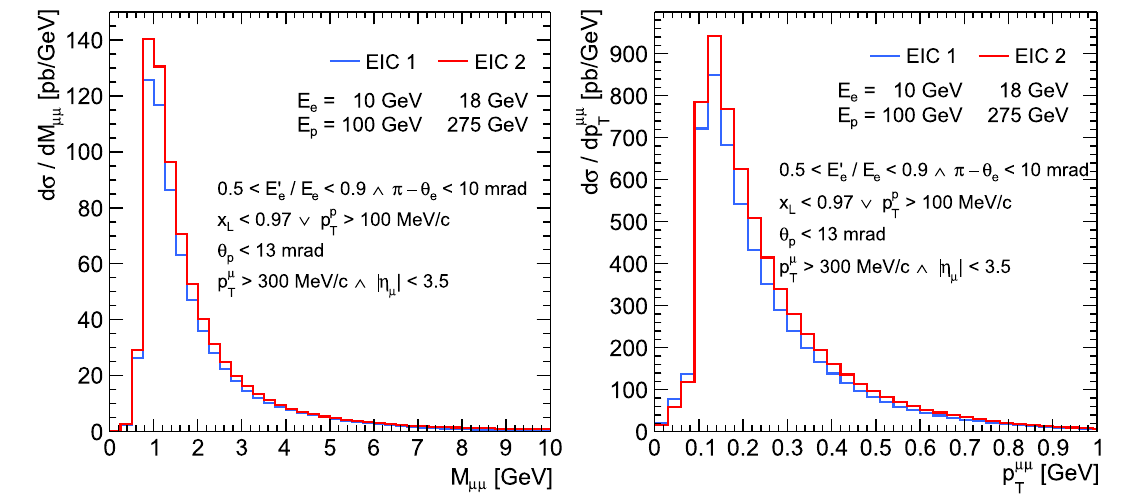
Fig. 1 a The “observed” cross-section as a function of the invariant mass M μμ for the selected events according to the set of cuts (2), without the photon veto, for the high (red histogram) and low (blue histogram) energy collisions at the EIC; b the corresponding cross-sections for the muon μμ pair as a function of p